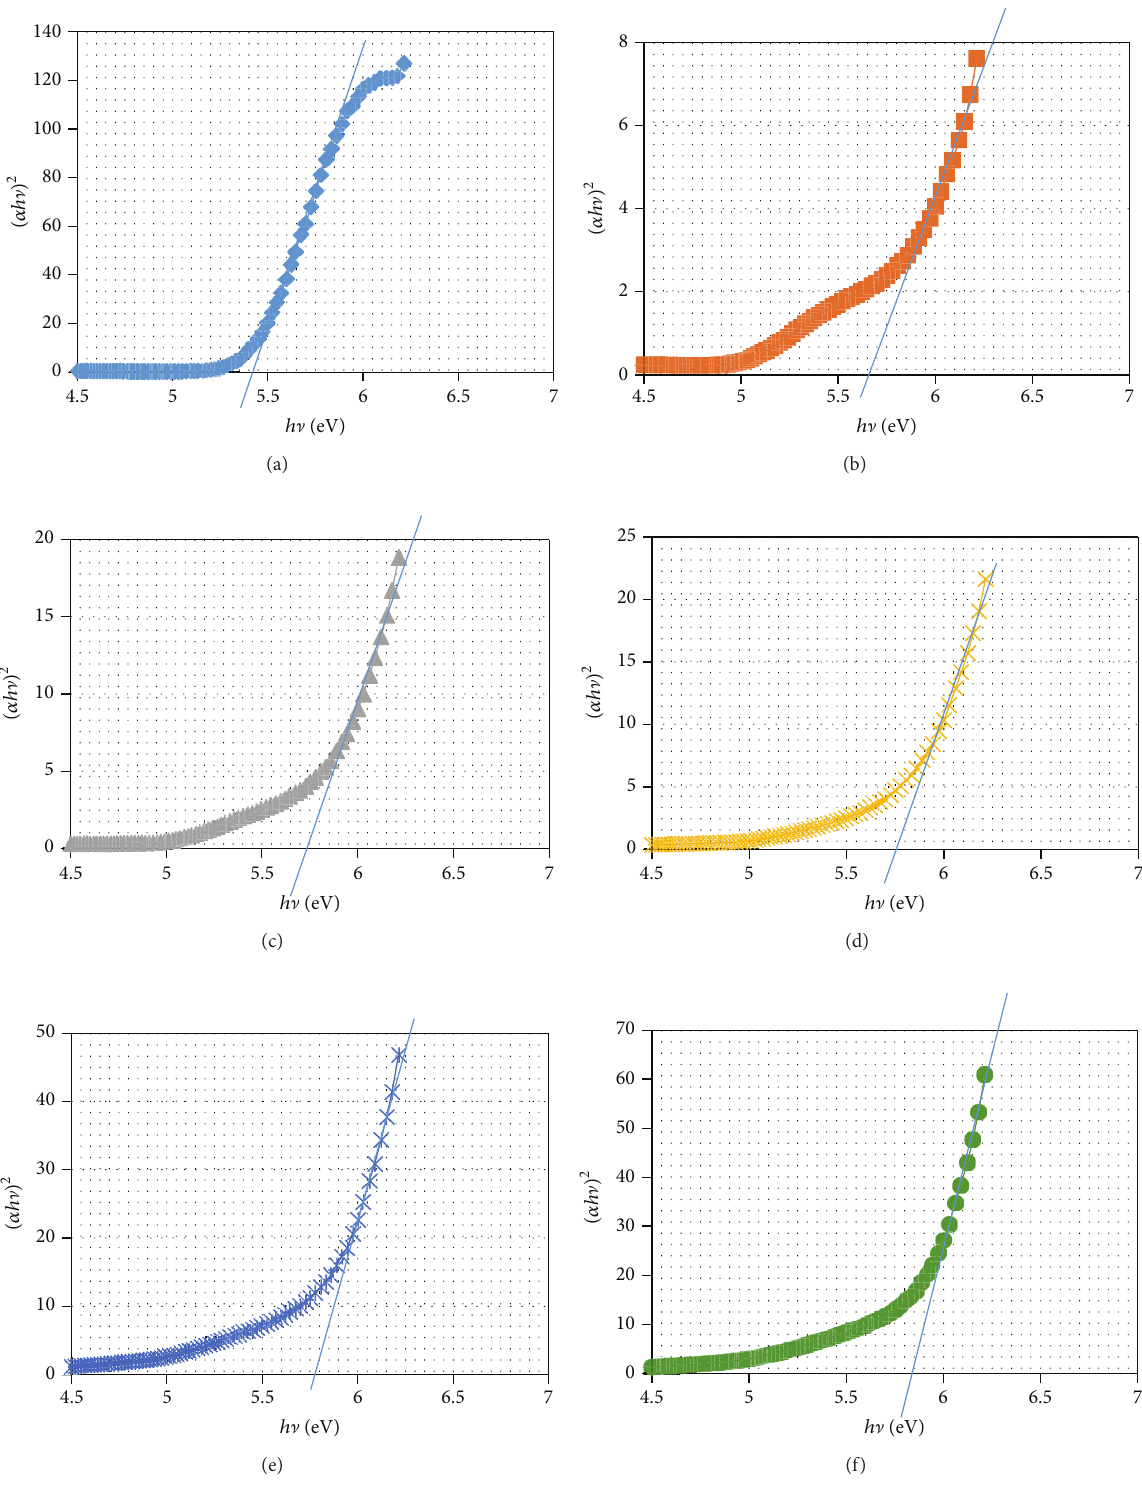
Figure 2: Plot of (𝛼ℎ V ) 2 versus photon energy (ℎ V ) for pure PVA and PPVA films with five mole ratios: (a) pure PVA; (b) 0.1; (c) 0.2; (d) 0.3; (e) 0.4; and (f)